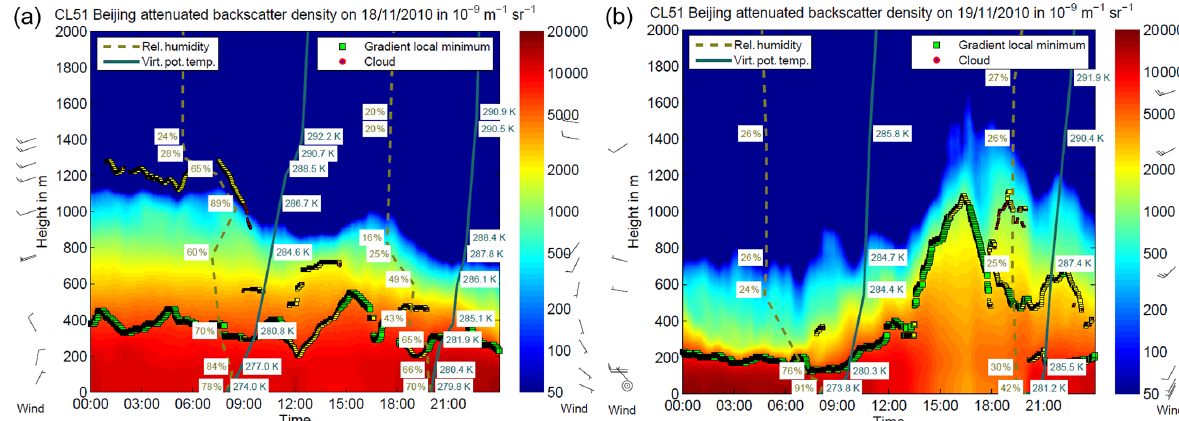
Figure 2. Observed attenuated backscatter density, calculated mixing layer height using ceilometer and vertical wind speed, wind direction, relative humidity, and virtual potential temperature using sounding data during 18 November (a) and 19 November (b) . The black flags on the left- and right-hand sides of the figures stand for vertical wind speed and wind direction obtained from sounding measurements at 08:00 and 20:00 Beijing time, respectively. The circle on the left-hand side of the figure represents calm wind. The dotted yellow lines and solid green lines represent the vertical distribution of virtual potential temperature and relative humidity from sounding at 08:00 and 20:00, respectively. The yellow square and green square represent the first layer and second layer, respectively, and usually the first layer was used as the mixing layer height. The mixing layer height was determined from the local minimum of the backscatter density gradient, and the colour in the figure stands for backscatter density from the ceilometer. From both figures, we can clearly see that the mixing layer has an important role in regulating the distribution of air